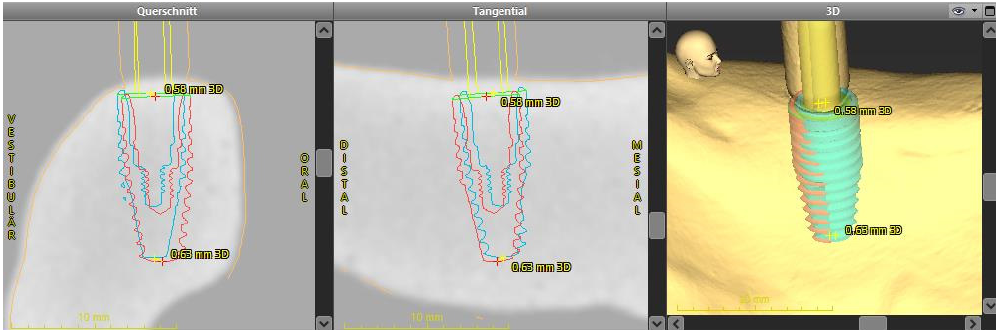
Figure 5. Overlay of the planned and actual achieved implant position using the treatment evalua- tion program function of coDiagnostiX